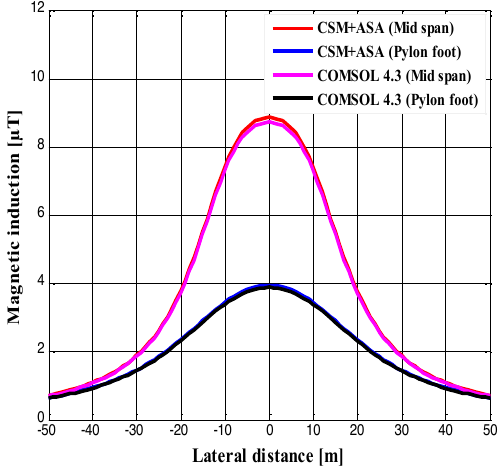
Figure 22: Comparison of magnetic induction levels between proposed method and COMSOL 4.3a